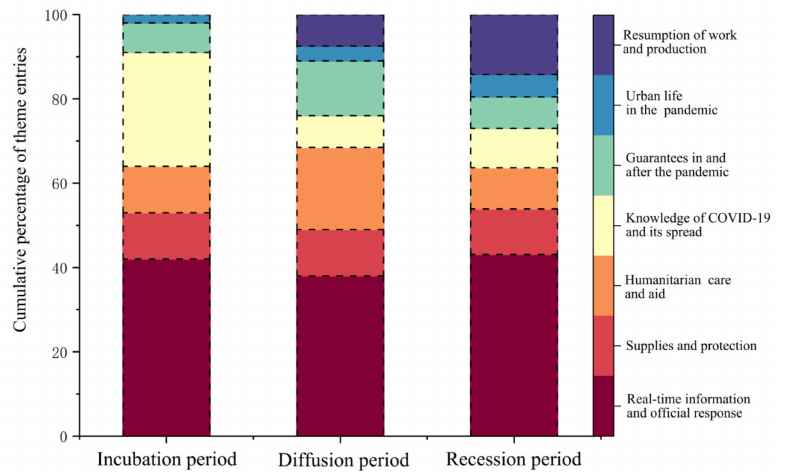
Figure 2. Thematic evolution with percentage in three